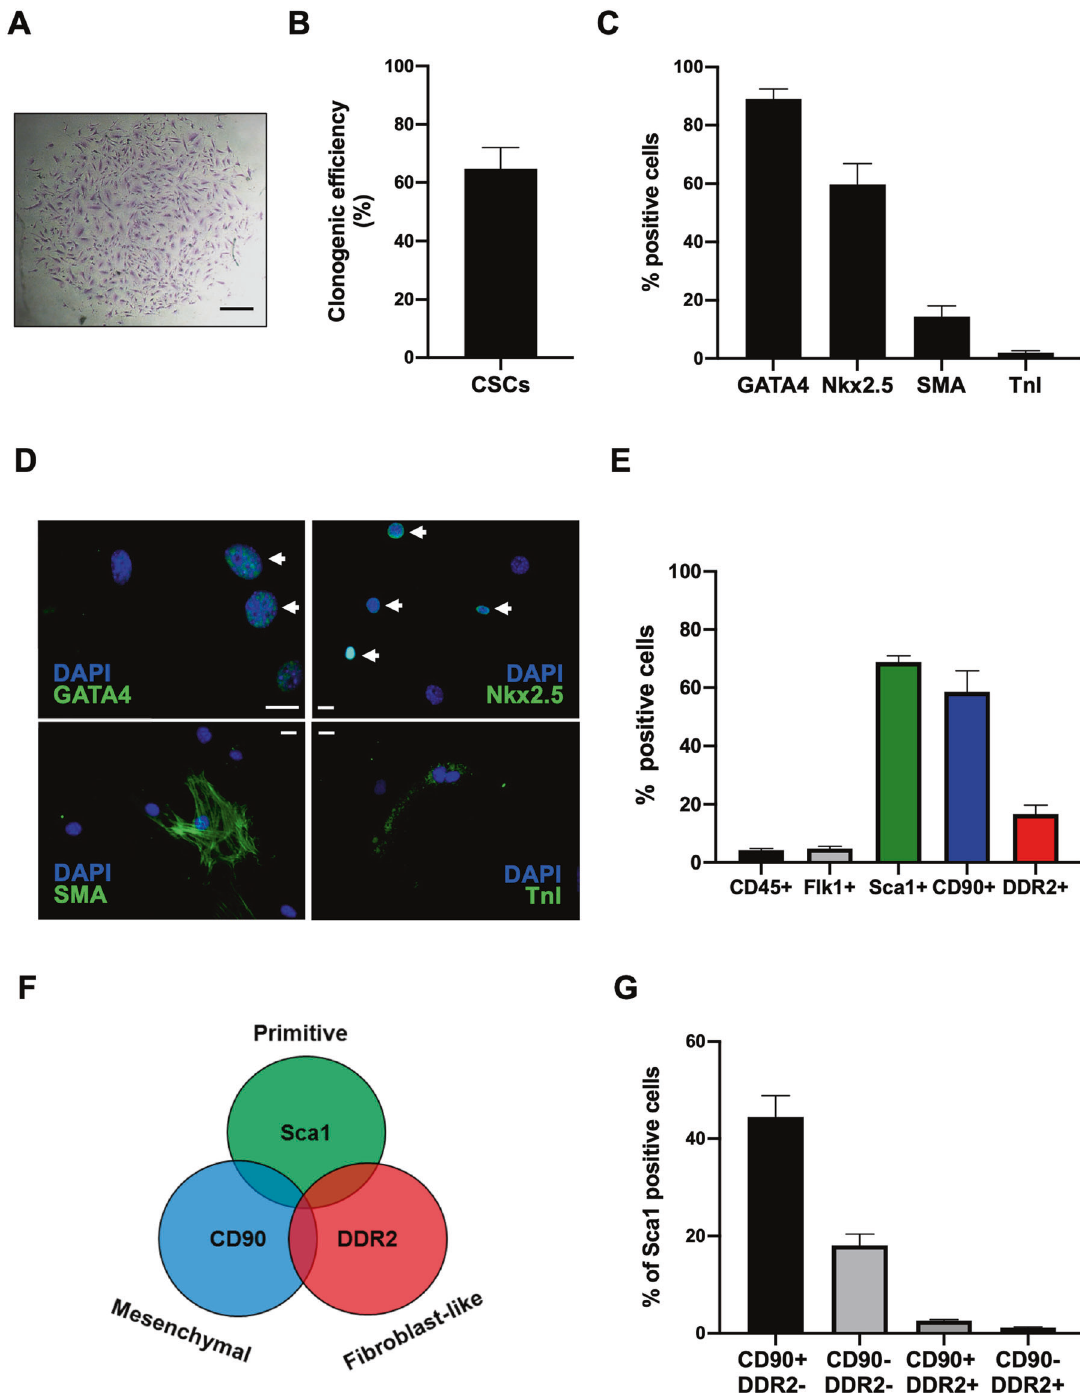
Fig. 1 CSC characterization. A Representative microscopy image of a fi xed GIEMSA-stained CSC colony. Scale bar = 500 µm. B Quanti fi cation of clonogenic ef fi ciency ( n = 6). C Quanti fi cation of positive cells ( n = 5), and representative immuno fl uorescence panels ( D ) for selected cardiac markers (GATA4, Nkx2.5, TnI, SMA). Arrows indicate positive nuclei. Scale bars = 20 µm. E Quanti fi cation of single marker positivity by fl ow cytometry analysis of the whole CSC population ( n = 5). F Conceptual scheme of the association among the Sca1, CD90, and DDR2 markers with corresponding phenotypes. G Quanti fi cation by fl ow cytometry of the percentage of CD90 or DDR2 cells among the CD45-/Flk1-/Sca1 + population ( n = 3). not modulate CSC immunophenotype after 32 hours of nutrient Autophagy stimulation enriches the primitive fraction of CSCs deprivation (Supplementary Fig. 5), TRE pre-treatment, on the We then checked whether autophagy stimulation affects the other hand, preserved a signi fi cantly higher proportion of Sca1 + relative cell-type composition within the CSC population by the use cells after stress, including the Sca1 + /CD90 + /DDR2- primitive of fl ow cytometry to evaluate the surface marker expression (Fig. mesenchymal fraction (Fig. 4A, B). By contrast, the proportion of 1E, F). While Ad-ATG7 transduction and si-ATG7 transfection did Cell Death Discovery (2022)